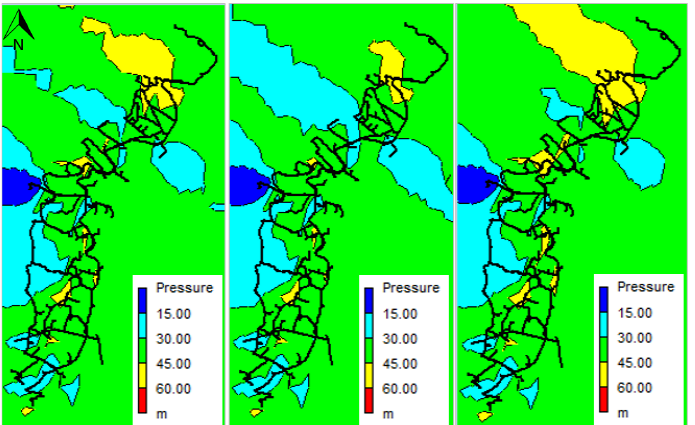
Figure 13. Pressure variation in the Gaula WDN—average, peak, and maximum pressure scenarios (proposed solution).